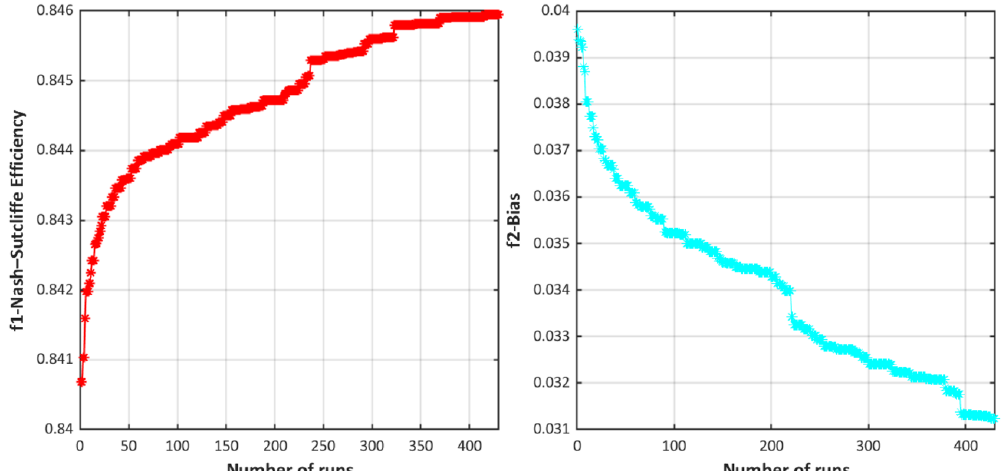
Figure 6. NSGA-II dynamical performance plots for both objective functions vs. the number of evaluations for model M01 over Baskatong catchment.